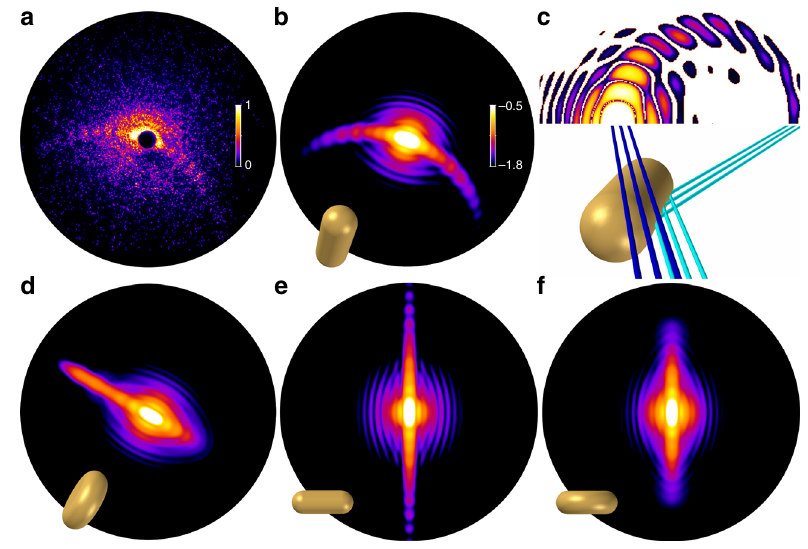
Fig. 4 Unique identi fi cation of prolate pill-shaped structures. a Measured image (intensity in arbitrary units) and b matching simulation result of the wide-angle diffraction of a pill-shaped prolate droplet (logarithmic intensity in arbitrary units, color bar applies also to d – f ). The structure shape and orientation are visualized in yellow . The optical axis of the extreme ultraviolet beam is directed into the image plane, the tilt angle between the symmetry axis of the particle and the optical axis is 35°; the semi-minor axes a = b = 370nm and the semi-major axis c = 950nm; for optical parameters see “ Methods ” section. c Illustration of the origin of bent streaks occurring when a tilted rod-type structure diffracts the light. The constructive interference is analogous to the specular re fl ection at the surface of a macroscopic rod. Two particular bundles of constructively interfering rays are explicitly sketched, please note that the different ray colors do not refer to wavelengths, but are applied to facilitate distinction. d Simulated wide-angle diffraction image of a wheel-shaped oblate particle (semi-major/-minor axes as in b , tilt angle of 80° between the symmetry axis and the optical axis, which is directed into the image plane). If the oblate particle ’ s symmetry axis is neither oriented along the optical axis nor perpendicular to it, the diffraction patterns exhibit straight streaks to only one side. e , f Comparison of simulated wide-angle diffraction images of a prolate e and an oblate structure f aligned to the scattering plane, i.e., at 90° tilt angle between the symmetry axis and the optical axis, other parameters as in b , d . Though the 2D projections are similar and the 2D outlines identical, the intensity distributions of the straight streaks are clearly different and decay much faster for wheel-type than for pill-type